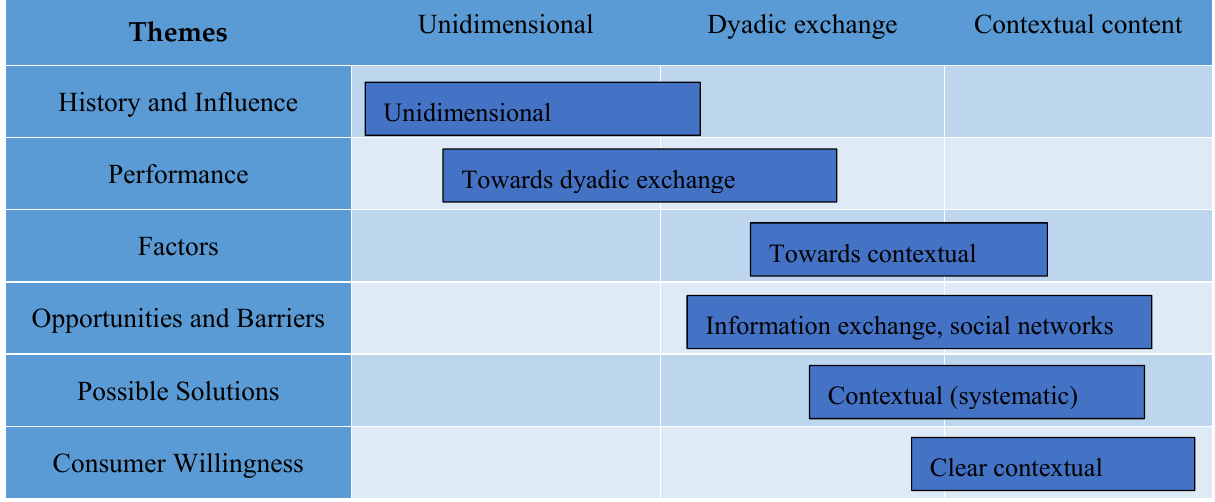
Figure 4. Logic of exchange.